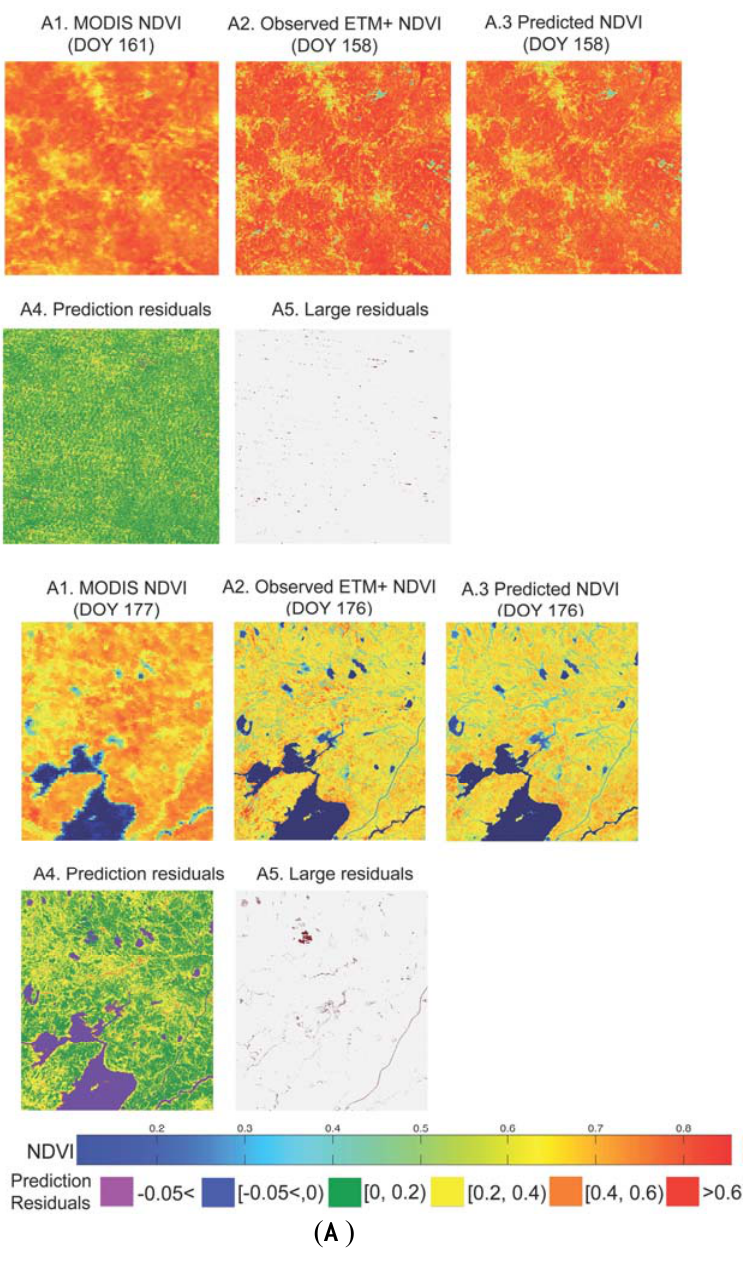
Figure 3. MODIS, Landsat NDVI validation, synthetic NDVI images and spatially explicit residuals corresponding to one time step ( k + 1) from the last Landsat observation for the 13 × 13-km subset of the site (A1–A5) and the 30 × 30-km subset of the Manitoba site (B1–B5). Prediction residual (A4 and B4) values are color coded: − 0.05 ≤ purple, − 0.05 < blue ≤ 0, 0 ≤ green < 0.2, 0.2 ≤ yellow < 0.4, 0.4 ≤ orange < 0.6, red ≥ 0.6. Plates A5 and B5 show residuals higher than ±0.25. ( A ) Zambezia site; ( B ) Arizona